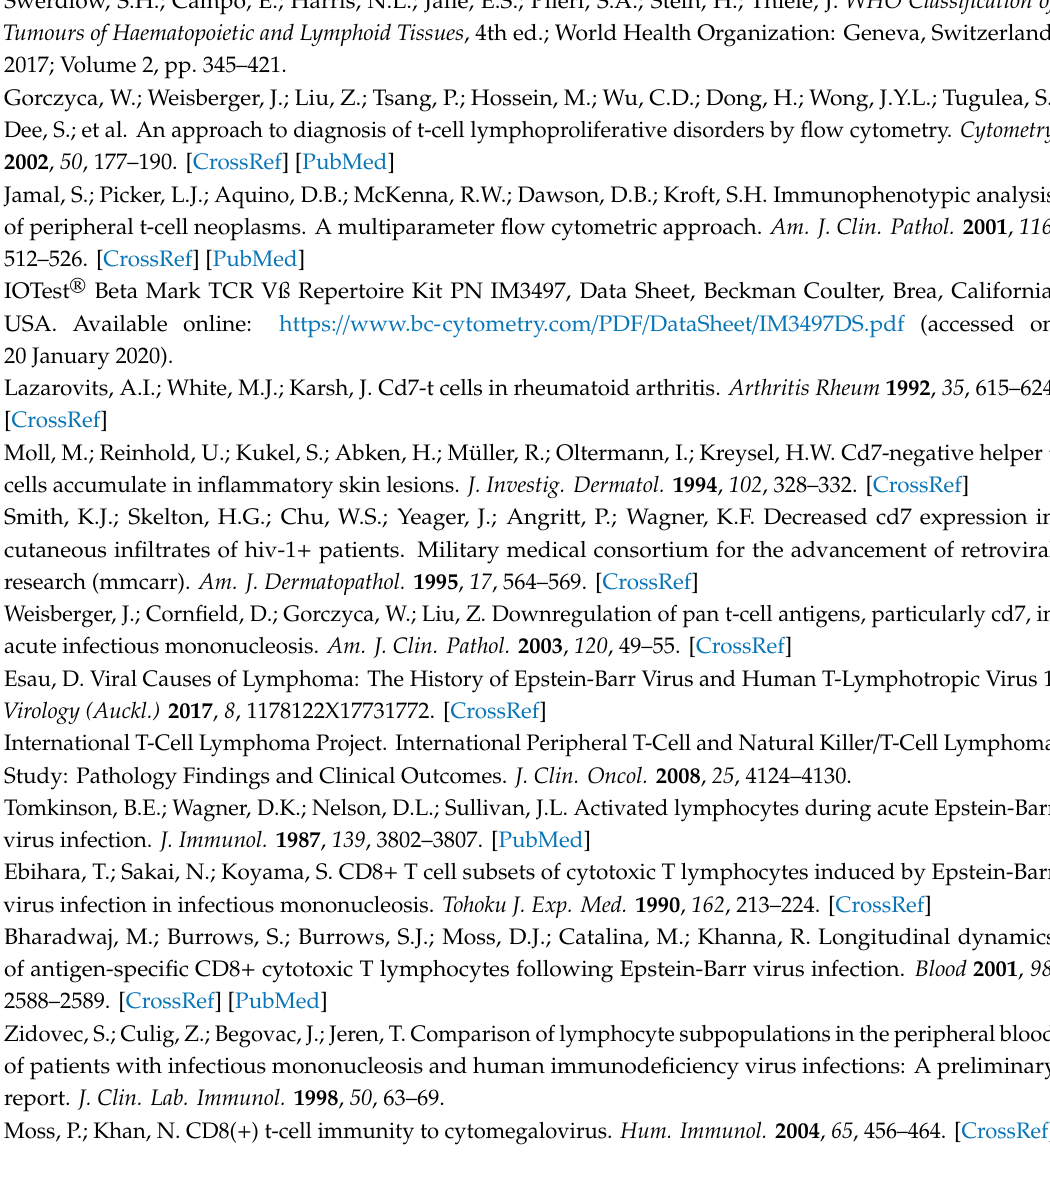
Figure S1: Repertoire diversity of the V β TCR in a healthy donor